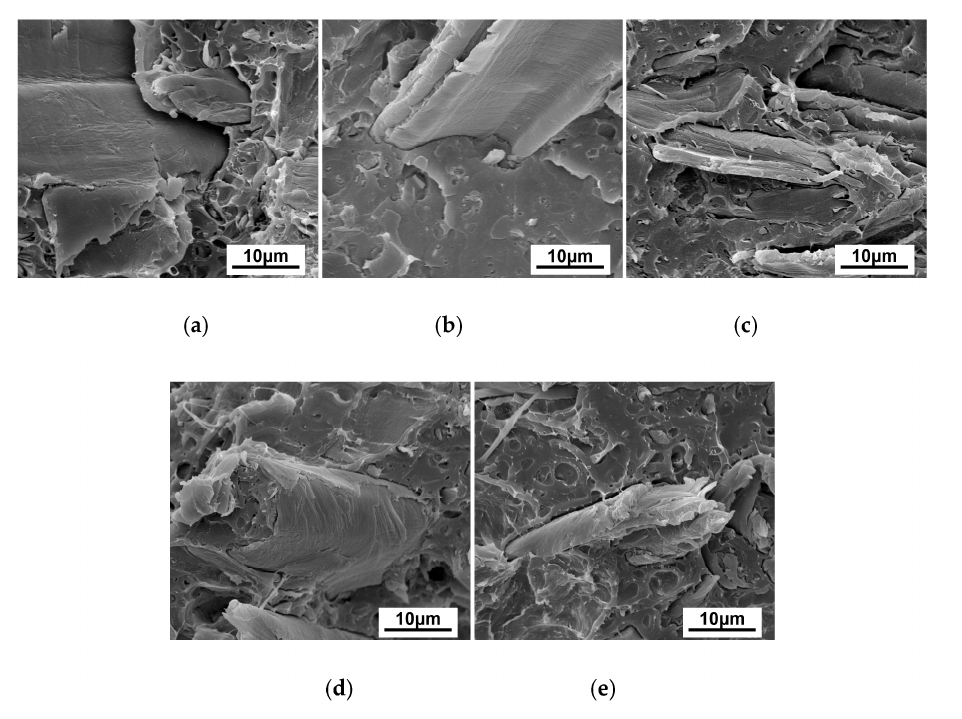
Figure 7. SEM micrographs of the fractured surface of wood flour/PLA composites with different PLA- g -St/MAH loading rates. ( a ) WP; ( b ) WPS1; ( c ) WPS2; ( d ) WPS3; ( e ) WPS4.